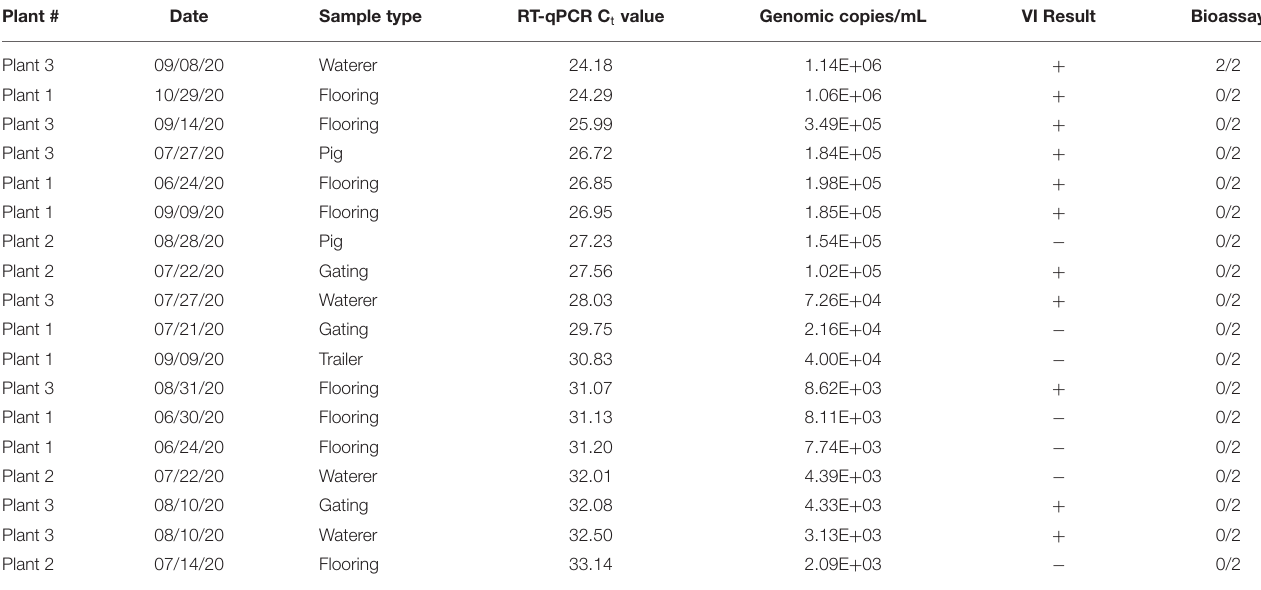
TABLE 1 | RT-qPCR, virus isolation (VI), and swine bioassay results of selected SVA samples from Plants 1-3. Plant